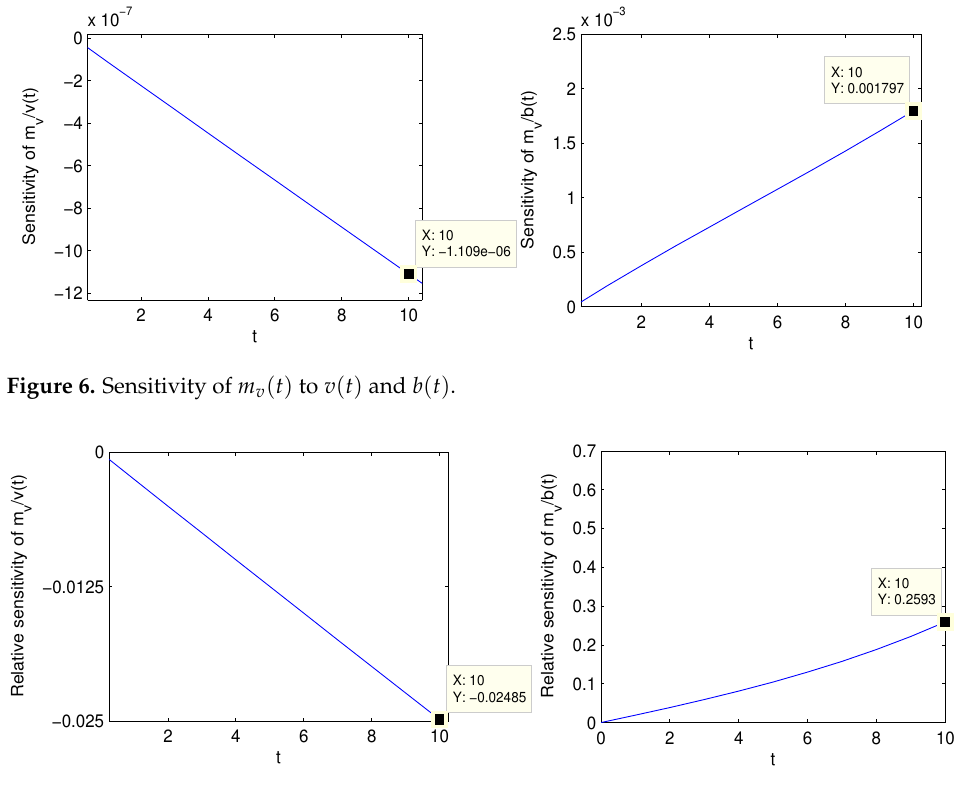
Figure 7. Relative sensitivity of m v ( t ) to v ( t ) and b ( t )